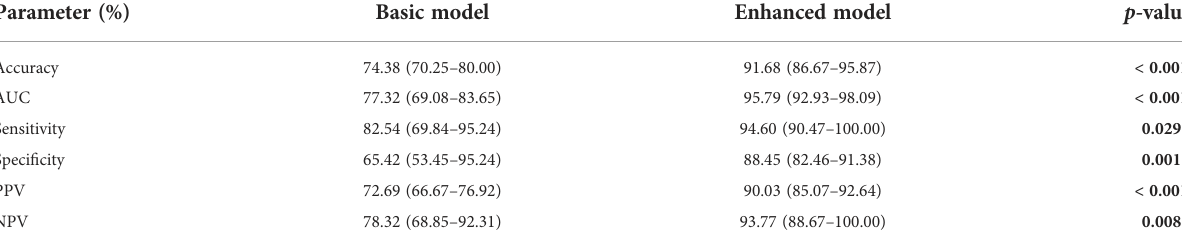
TABLE 3 Performance of basic model and enhanced